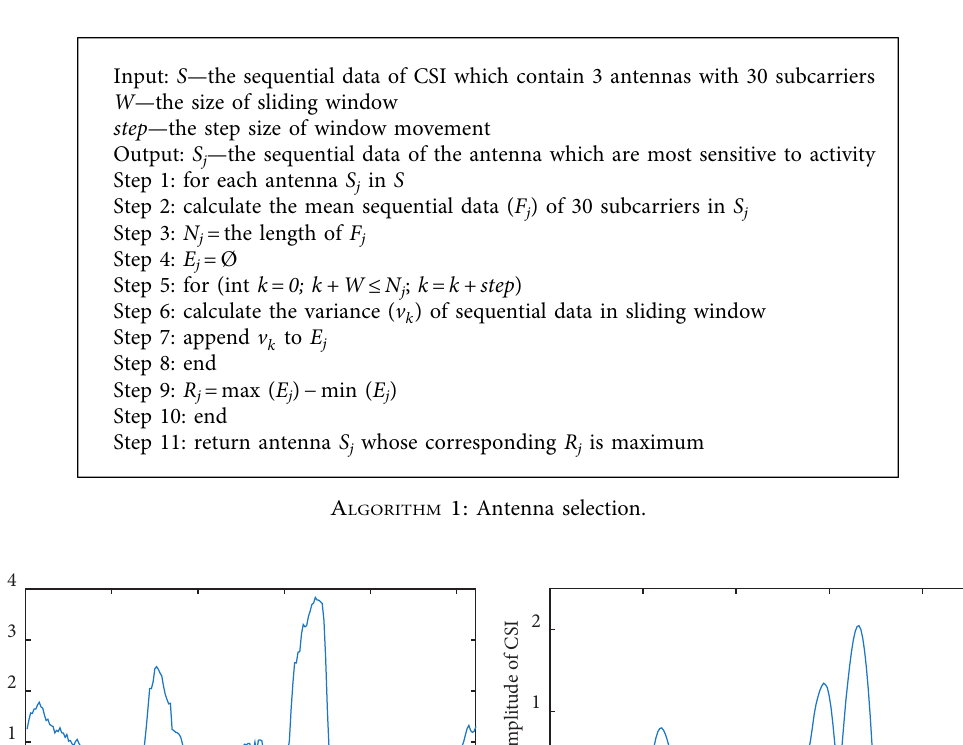
Figure 4: Comparison of sensitivity of different antennas. CSI sequences (a) formed by fusion of 30 subcarriers of each antenna and (b) after sliding window variance based on (a).